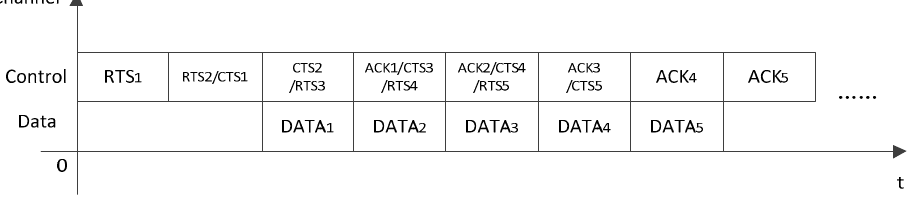
Figure 4. Merging the request to send (RTS), clear to send (CTS), and acknowledgement (ACK) stages into one control channel.